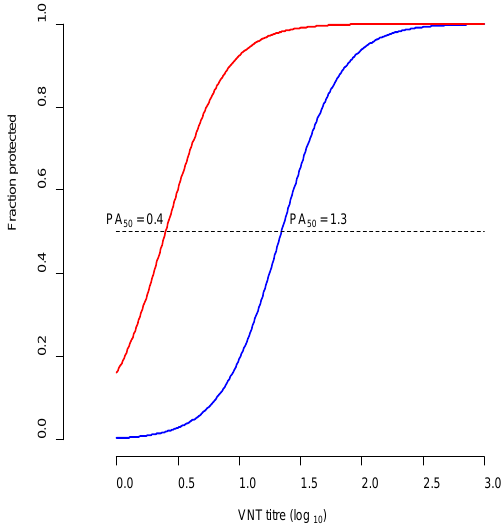
Figure 2. Logistic regression plot showing the relationship between VNT titres against A/IRN/22/2015 (representative A/G-VII field isolate) of cattle vaccinated with A/G-VII vaccine on the day of challenge (21 days post vaccination) and protection. The red line indicates protection after challenge with A/IRN/22/2015, and the blue line indicates protection after challenge with A/IRN/10/2018. Horizontal dotted line for 50 percent protection intersects the regression lines at the PA 50 values for A/G-VII and A/IRN/05 protection.